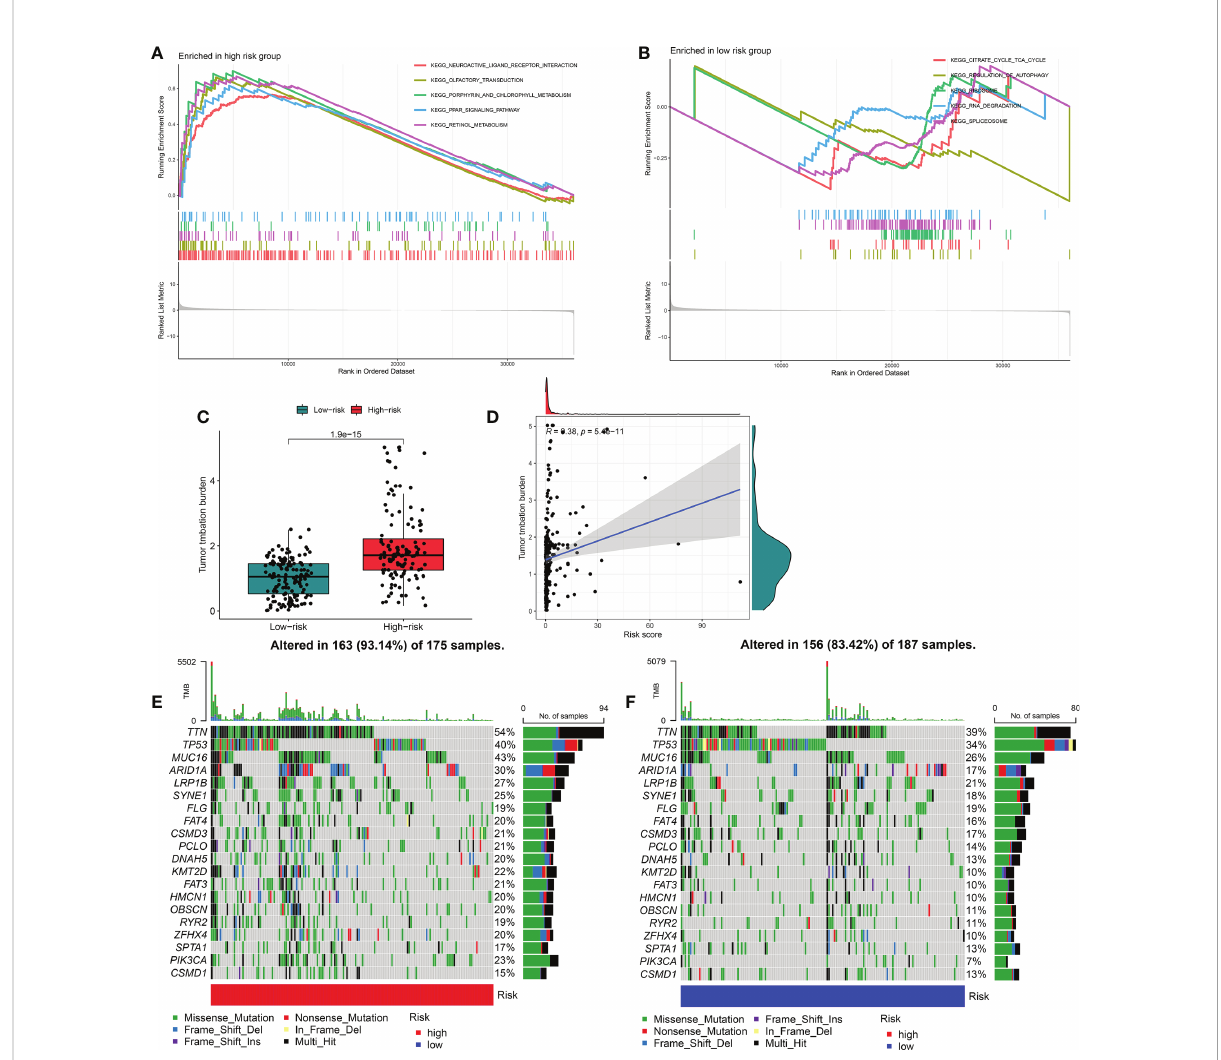
FIGURE 6 Molecular characterization and somatic variations of the distinct FRGPI subgroups. (A) Gene set enrichment analysis of risk hi in TCGA-KIRP cohort. (B) Gene set enrichment analysis of risk hi in TCGA-KIRP cohort. (C) Expression analysis of TMB in risk hi and risk lo groups. (D) Correlation analysis between TMB and risk score. (E) Mutational landscape of the risk hi groups in TCGA-KIRP cohort. (F) Mutational landscape of the risk lo groups in TCGA-KIRP cohort. TMB, tumour mutational